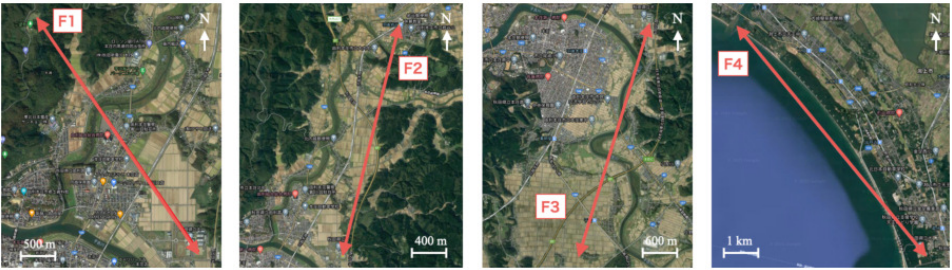
Figure 9. Flight communication experiments of four